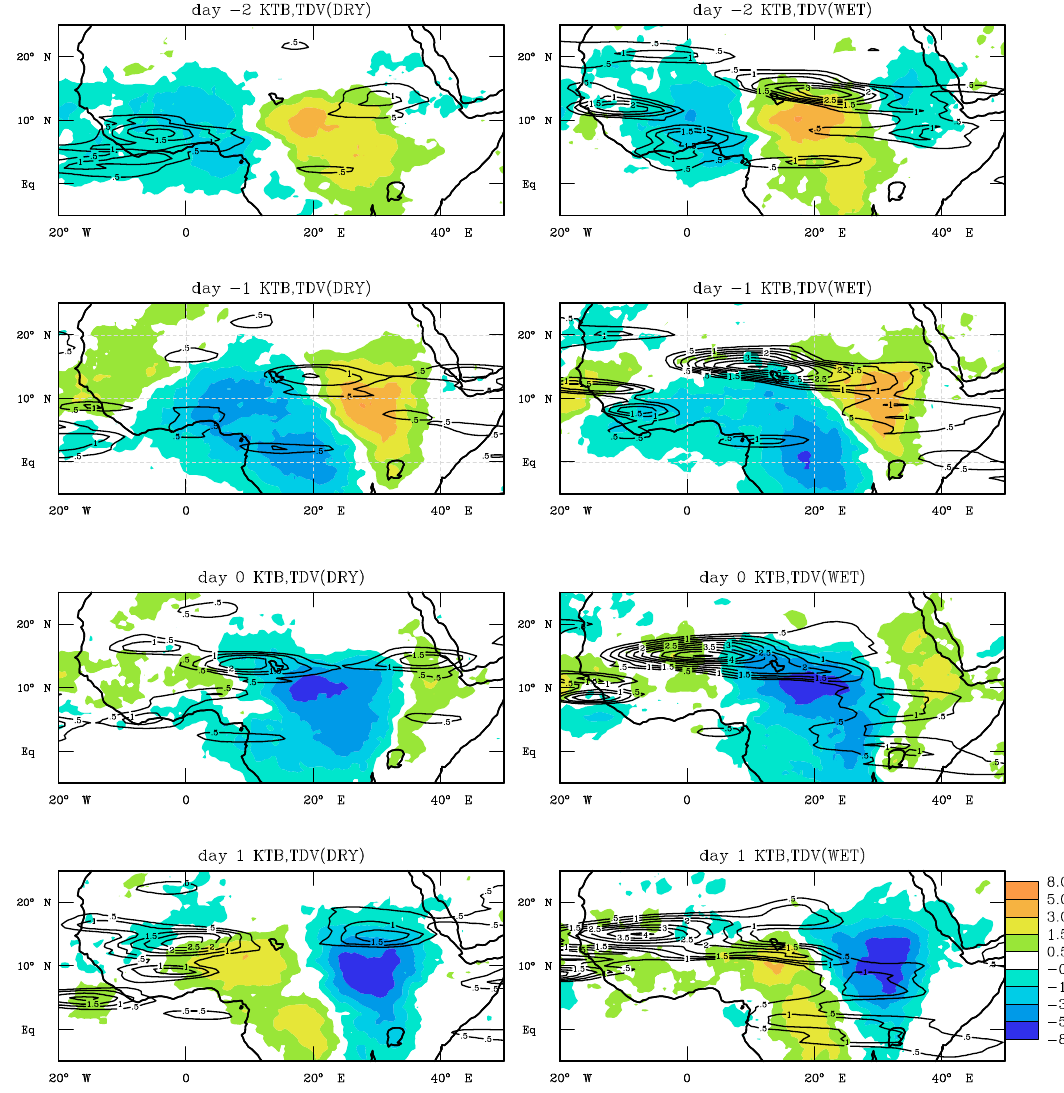
Figure 9. Kelvin wave regression composite anomalies of T B (K; shaded as shown in the legend) and AEW activity (K 2 ) associated with Kelvin filtered T B during dry (left panel) and wet (right panel) years. AEW activities are contoured every 0.5K 2 . Negative AEW variance anomalies are not shown for clarity.